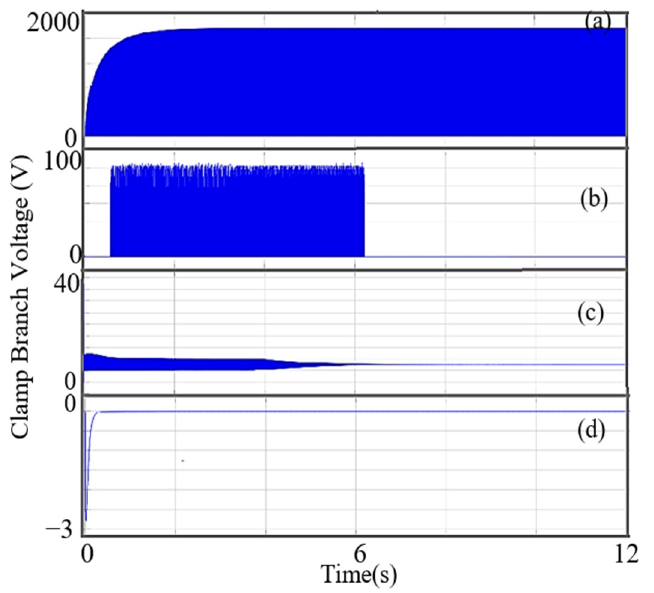
Figure 10. Clamp branch voltage of BDC ( a ) without snubber ( b ) RCD Snubber ( c ) active clamp snubber ( d ) flyback snubber.